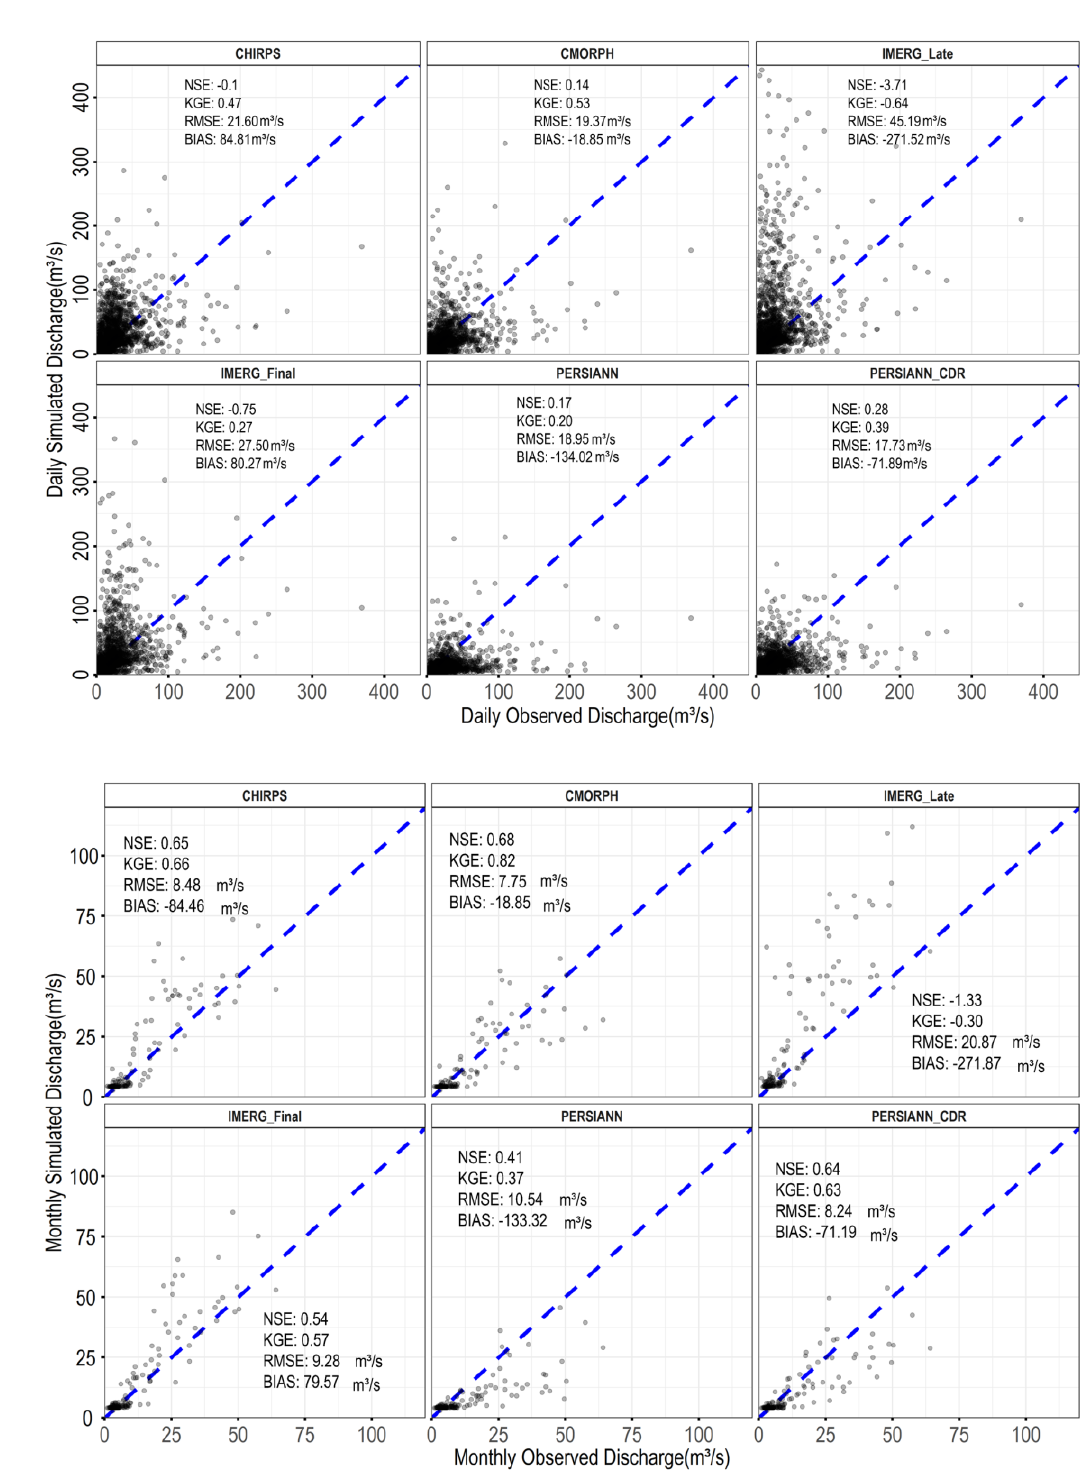
Figure 6. Scatter plots of daily ( a ) and monthly ( b ) simulated streamflow from CHIRPS, CMORPH, IMERG_Late, IMERG_Final, PERSIANN, and PERSIANN_CDR against corresponding gauge-based observed streamflow at the main outlet of the basin along with hydrological performance indicators NSE, KGE, RMSE, and BIAS. The blue dotted line denotes a 1:1 line.